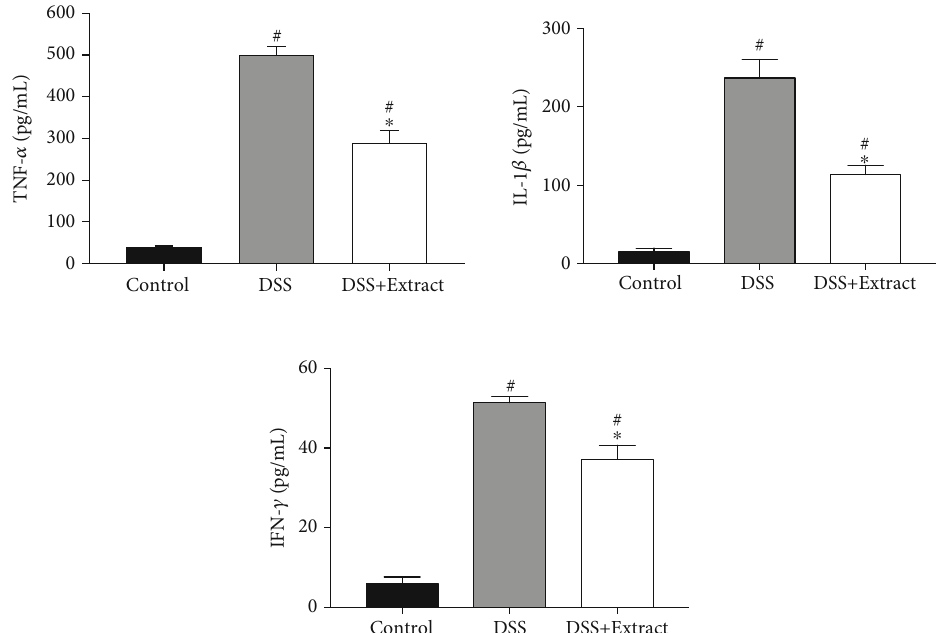
Figure 4: E ff ect of the C. procera methanolic extract on TNF α , IL-1 β , and IFN γ serum levels. Data presented are mean values from all three groups ( n = 6 ). ∗ represents signi fi cant di ff erences vs DSS group ( P < 0 : 0001 ) and # P < 0 : 0001 vs Control group (one-way ANOVA).